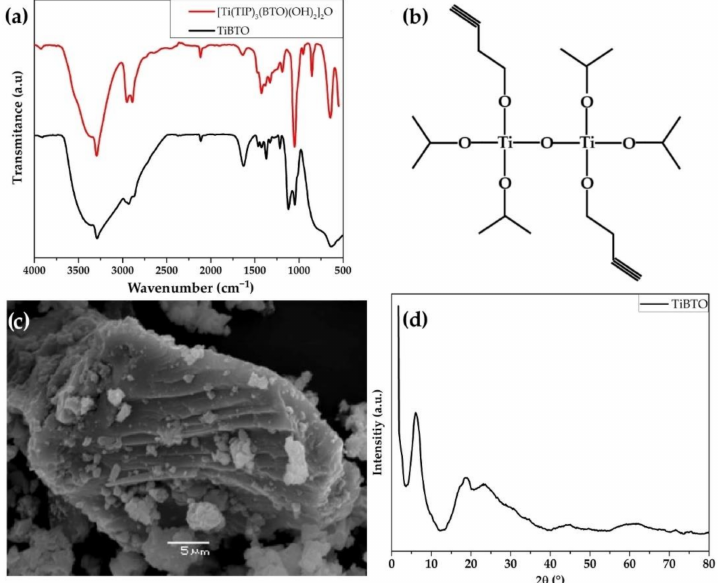
Figure 1. Infrared spectrum (FTIR) of TiBTO ( a ); scheme molecular dimer [Ti(TIP) 3 (BTO)(OH) 2 ] 2 O (mp–TiBTO) ( b ); SEM micrograph ( c ); and diffractogram of TiBTO ( d